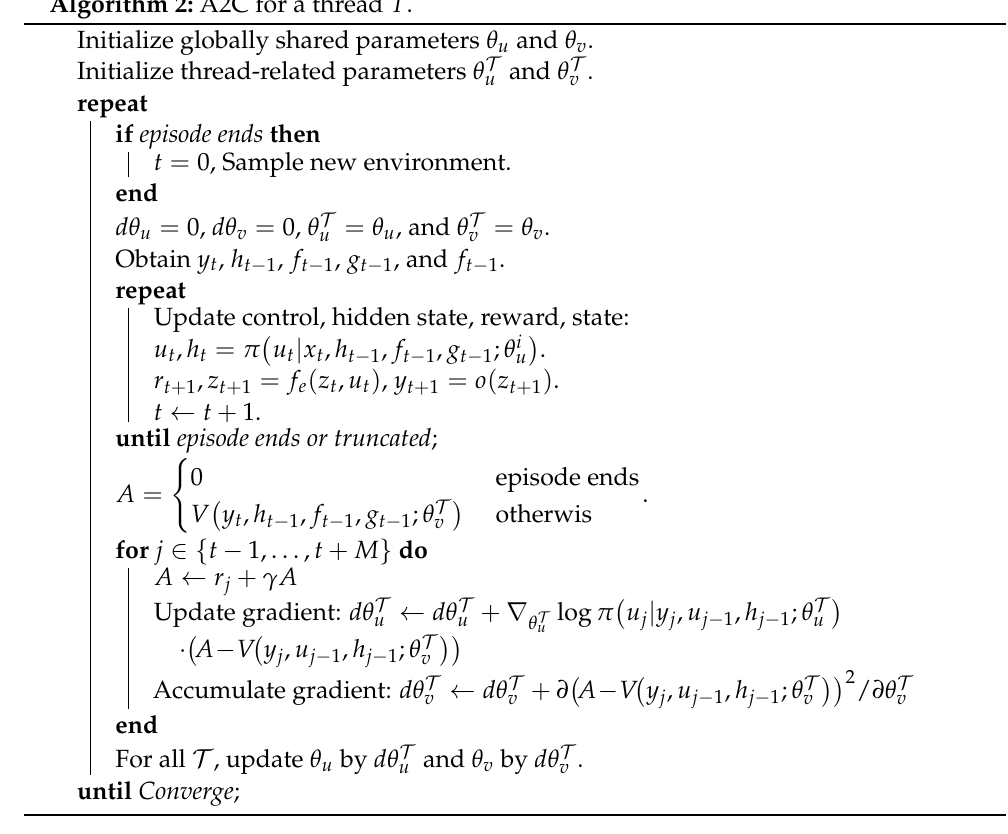
Algorithm 2: A2C for a thread T